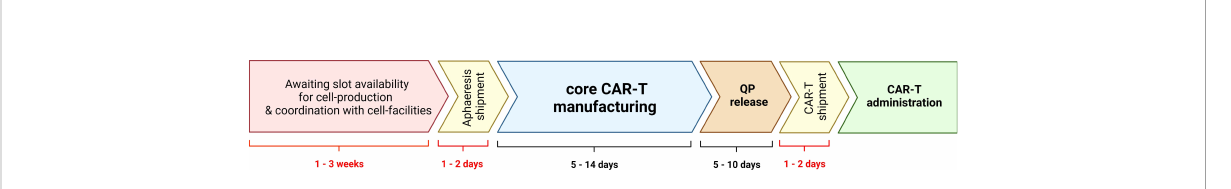
FIGURE 1 Steps required for autologous chimeric antigen receptor T-cell administration. Tentative timelines are added for reference. QP, quali fi ed